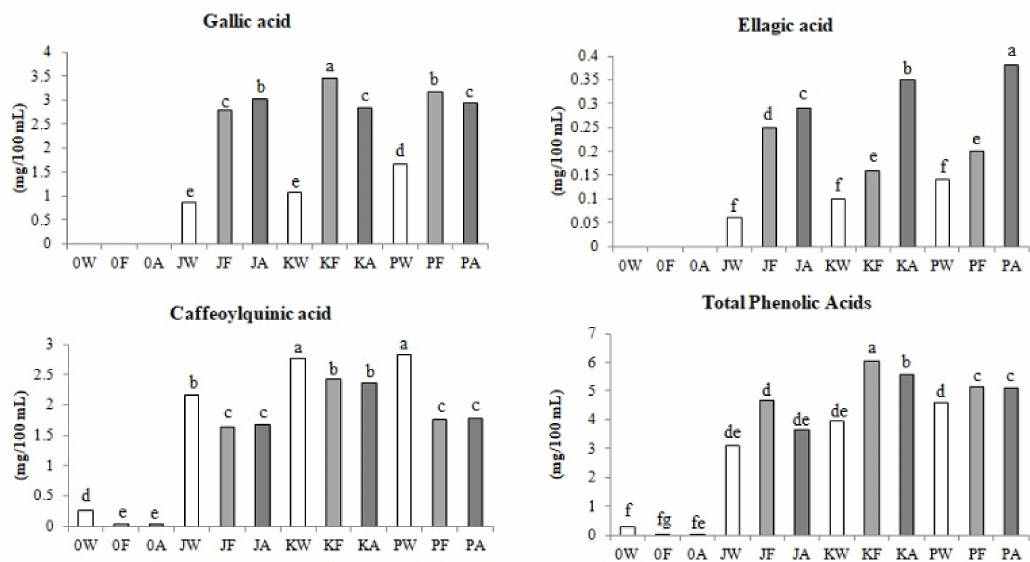
Figure 2. Changes in phenolic acids content (mg/100 mL) during control and fruit mead production technology. White bars—worts (W), light gray bars—samples after fermentation (F), dark gray bars—meads after aging (A). Sample codes: 0—control, J—samples with ‘Jantarnyi’ juice, K—samples with ‘Koralowyi’ juice, P—samples with ‘Podolski’ juice. Mean values with different letters: a, b, c, d, e, f are statistically different ( p <